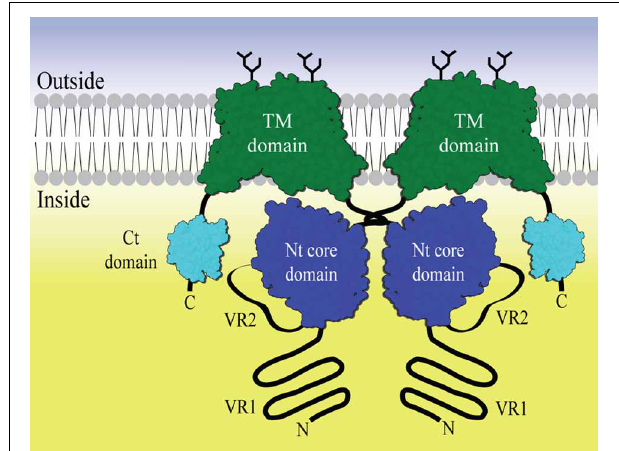
FIGURE 1 | The general domain structure of a SLC4 bicarbonate transporter represented as a dimer. The Transmembrane (TM) domain is shown in green. Dimerization is driven by dimerization arms close to the Nt core domains (blue) in the cytoplasm. Variable region 2 (VR2) is drawn as an extended loop from the core domain. Variable region 1 (VR1) is shown as an N- terminal extension from the core domain. The C- terminal region often contains a small PDZ domain (Kennedy, 1995) (cyan). Glycosylations are shown as black